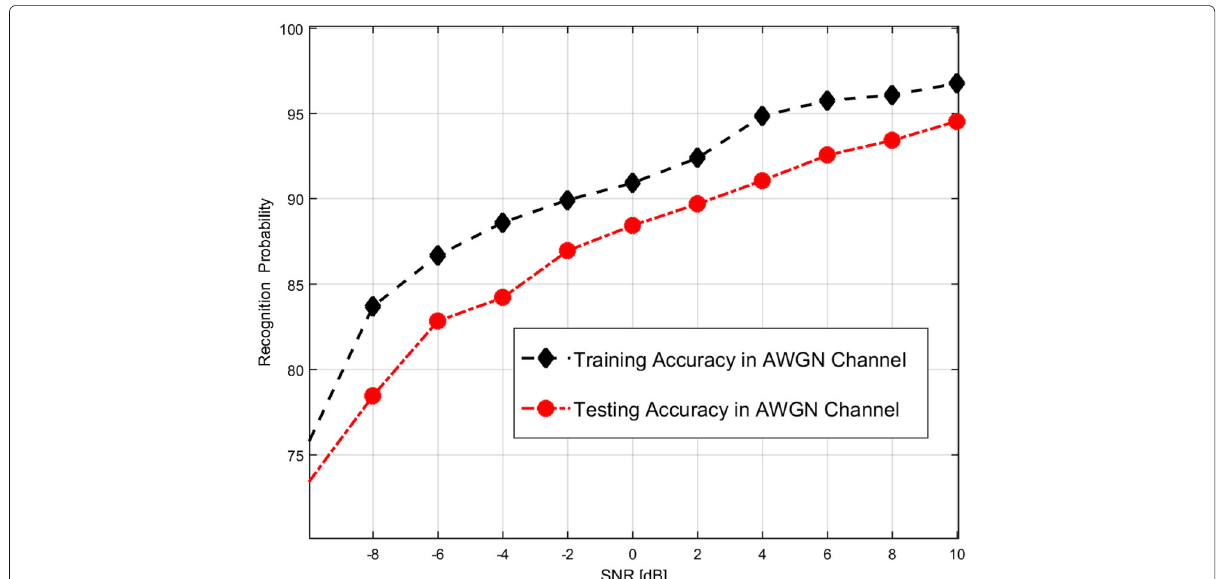
Fig. 5 φ 4 in the AWGN channel